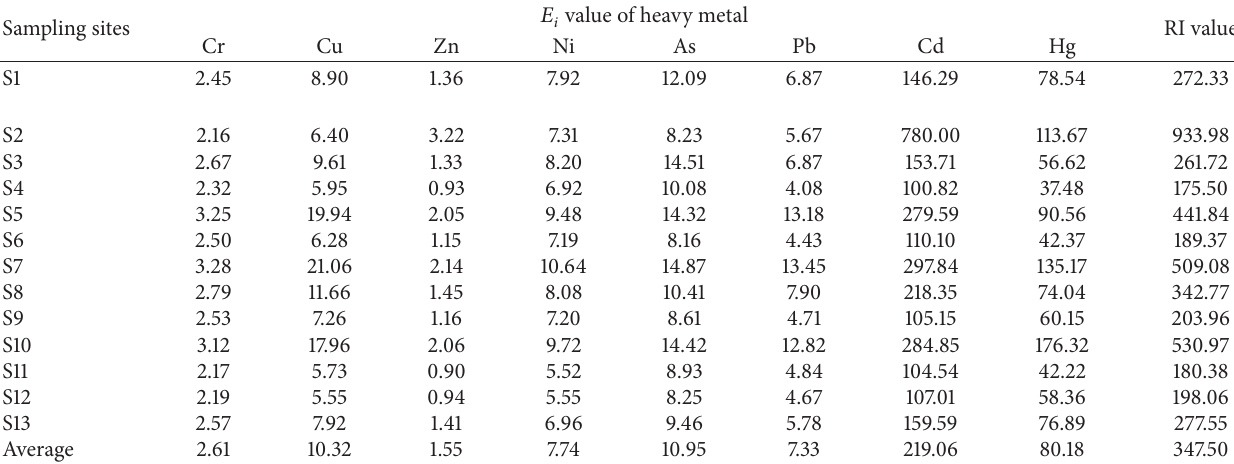
Table 6: The 𝐸 𝑖 and RI values of heavy metals in surface sediment from TGR. Sampling